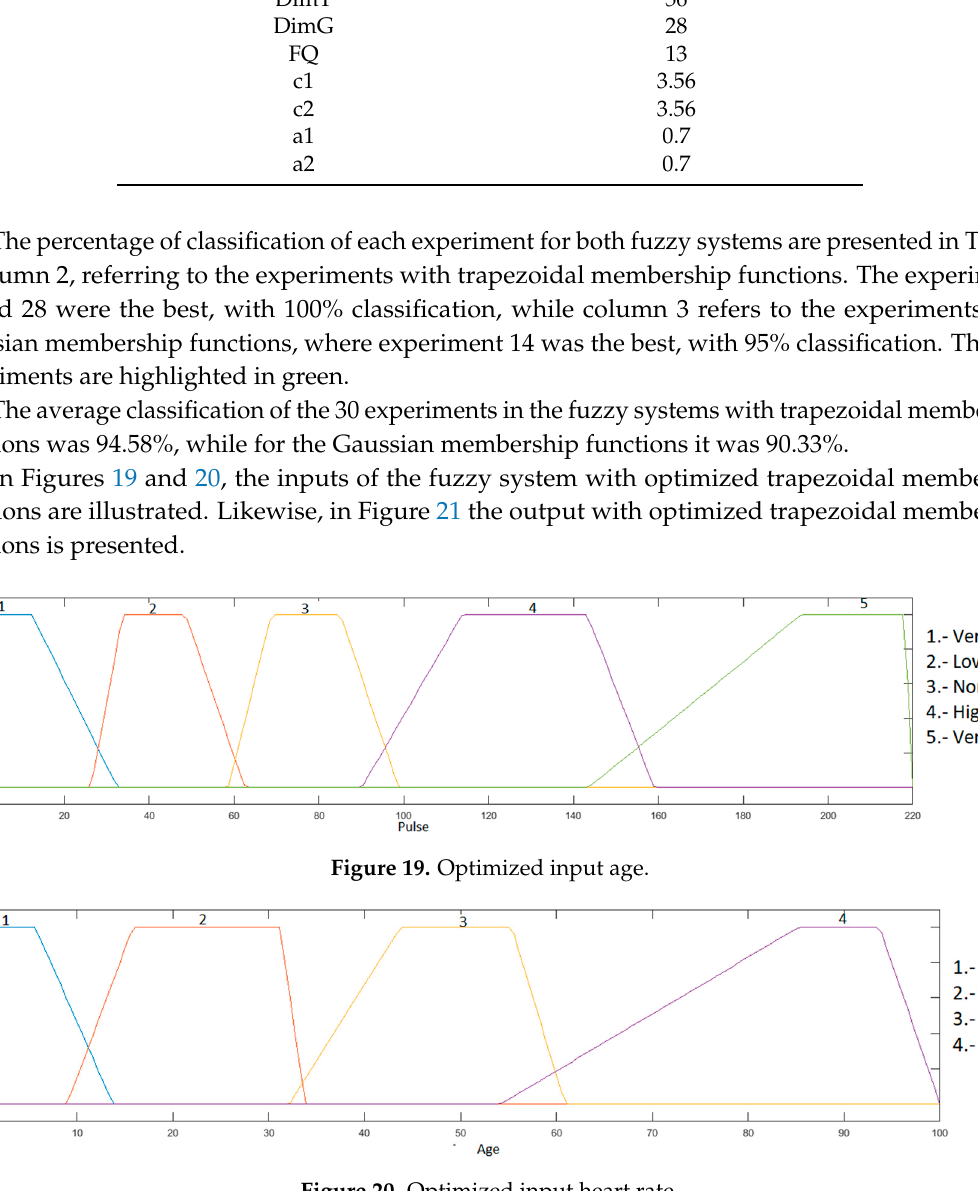
Figure 20. Optimized input heart rate.